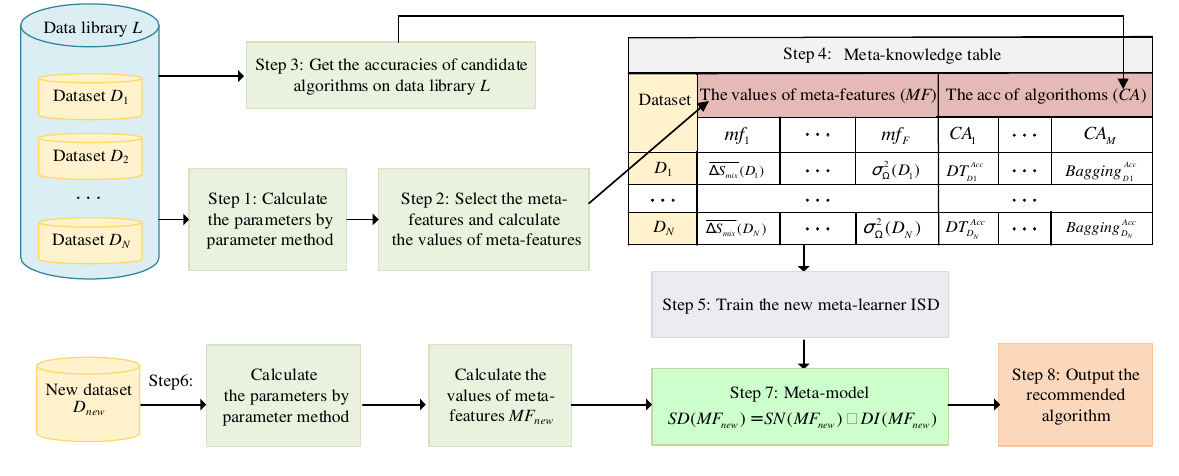
Figure 3. Schematic diagram of MLRM.